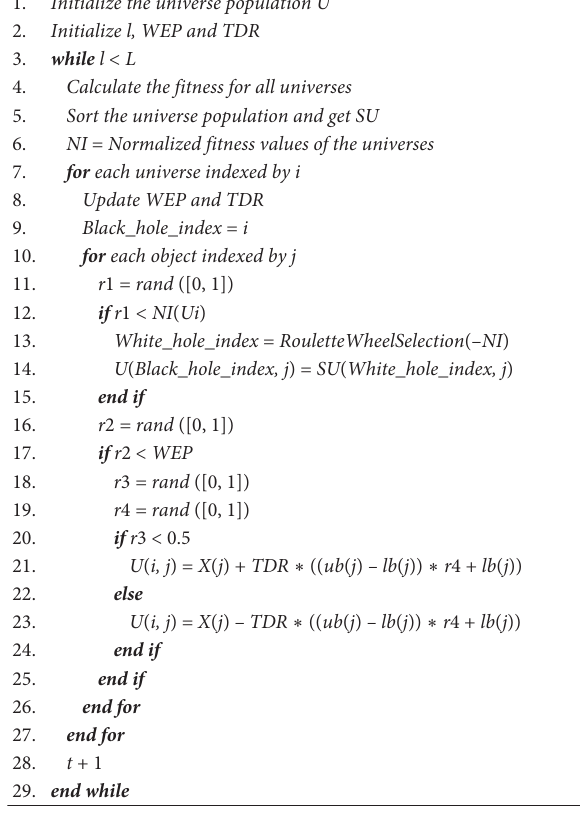
Figure 1: Pseudocode of MVO.